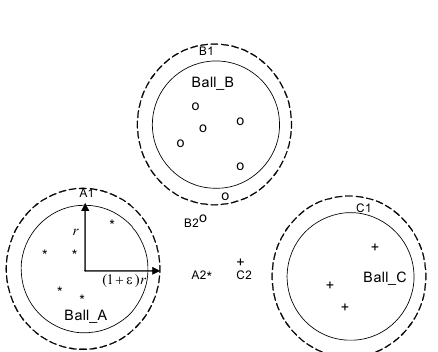
Figure 2. MEB clustering when the number of clusters is three. The MEB clustering algorithm of